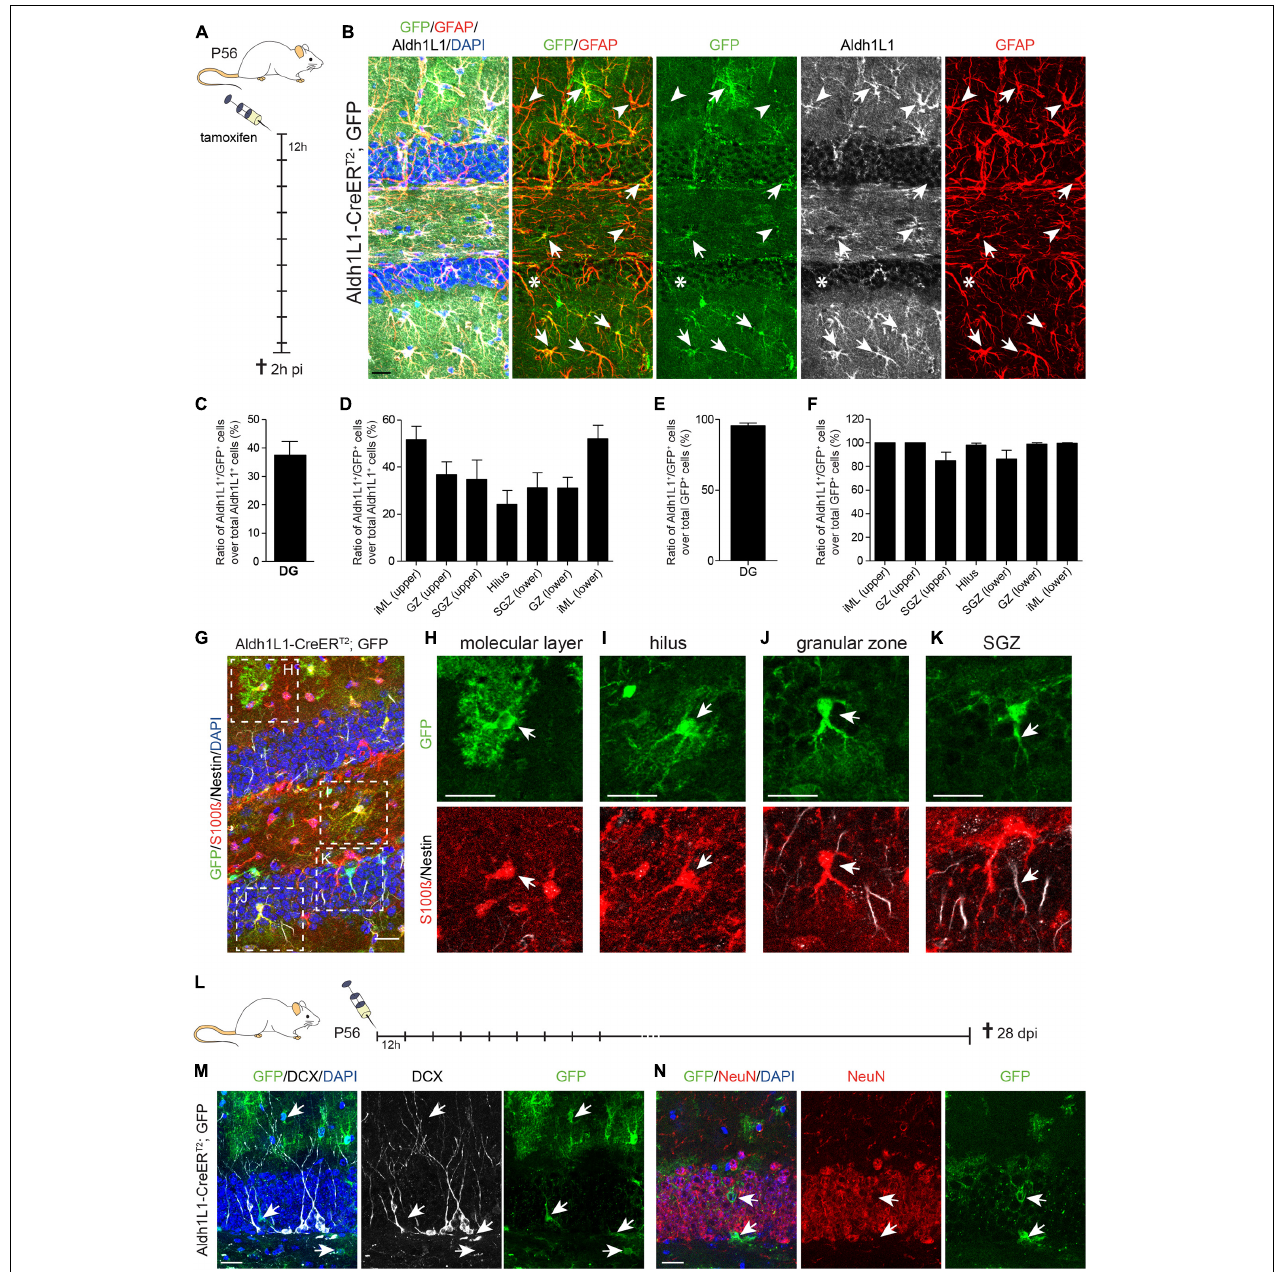
FIGURE 2 | Recombination in Aldh1L1-CreER T2 ; GFP mice efficiently and specifically targets astrocytes but not neural stem cells in the adult dentate gyrus. (A) Schematic drawing showing the short-term tamoxifen pulse. Here, Aldh1L1-CreER T2 ; GFP mice were injected with tamoxifen every 12 h (12 h) for five consecutive days and killed 2 h post-injection (2 h pi). (B) Representative pictures illustrate an overview of an immunohistochemically stained DG of adult Aldh1L1-CreER T2 ; GFP mice. Arrows point toward GFP/GFAP/Aldh1L1 triple positive cells while arrowheads highlight non-recombined GFAP + /Aldh1L1 + astrocytes. The asterisk marks a non-recombined GFAP + radial process of an adult NSC (DAPI in blue, GFP in green, GFAP in red, Aldh1L1 in white; scale bar = 20 µ m). (C,D) The graphs show recombination efficiency in adult DG astrocytes and adult DG astrocyte subtypes (mean + SEM). (E,F) The graphs show recombination specificity in adult DG astrocytes and adult DG astrocyte subtypes (mean + SEM). (G) Overview image of an immunohistochemically stained Aldh1L1-CreER T2 , GFP transgenic mouse DG using antibodies against GFP (green), S100 β (red), and Nestin (white) 2 h pi; DAPI is depicted in blue, scale bar = 20 µ m. (H–K) Representative pictures of astrocytes of each DG layer in [ (G) ; boxed areas] were chosen for magnification. Arrows point toward recombined GFP + astrocytes (green) expressing S100 β (red) in the molecular layer (H) , the hilus (I) , the granular zone (J) , and the subgranular zone [SGZ; (K) ] (scale bars = 20 µ m). (L) Schematic drawing showing the long-term tamoxifen pulse. Here, Aldh1L1-CreER T2 ; GFP mice were injected with tamoxifen every 12 h (12 h) for five consecutive days and killed 28 days post-injection (dpi). (M,N) Representative pictures of immunohistochemical staining against GFP (green) and DCX (white) and NeuN (red), respectively. Arrows point toward recombined GFP + cells, which do not co-express either DCX or NeuN; DAPI is depicted in blue; scale bar = 20 µ m.